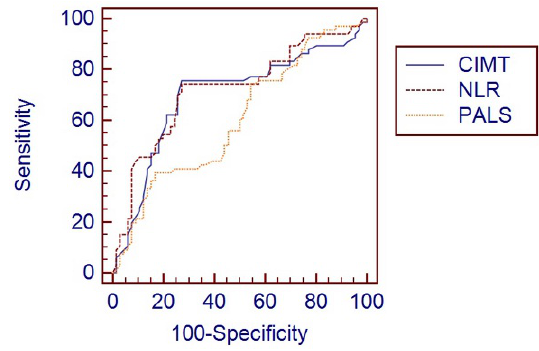
Figure 3 - Comparison ROC curves for the CIMT, NLR and PALS in the prediction of a longer TACT. ROC: receiver operating characteristic; CIMT: carotid intima-media thickness; NLR: neu- trophil to lymphocyte ratio; PALS: peak atrial longitudinal strain; TACT: total atrial conduction time.